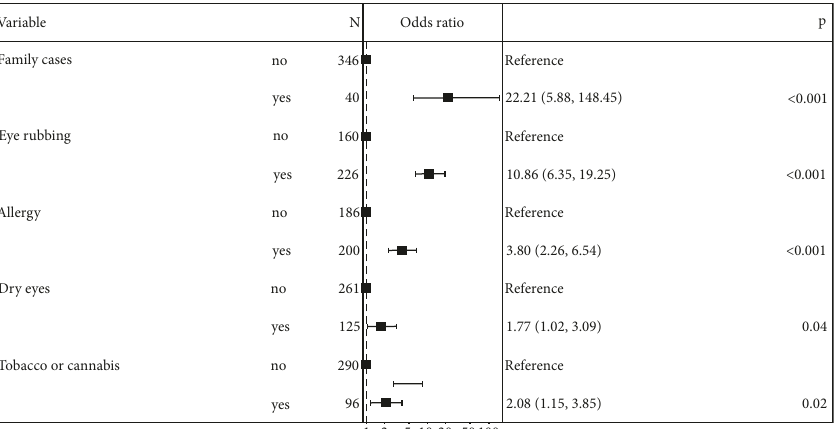
Figure 2: Forest plot of multivariate analysis of risk factors in the general population. Graphical representation of the odds ratio of the risk factors of keratoconus in the general population from the multivariate linear